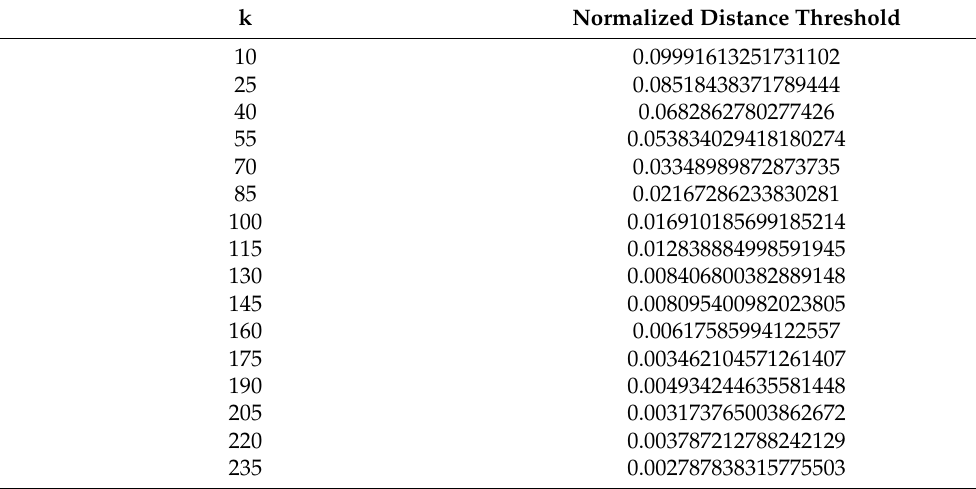
Table 3. Distance thresholds optimized by normalization.